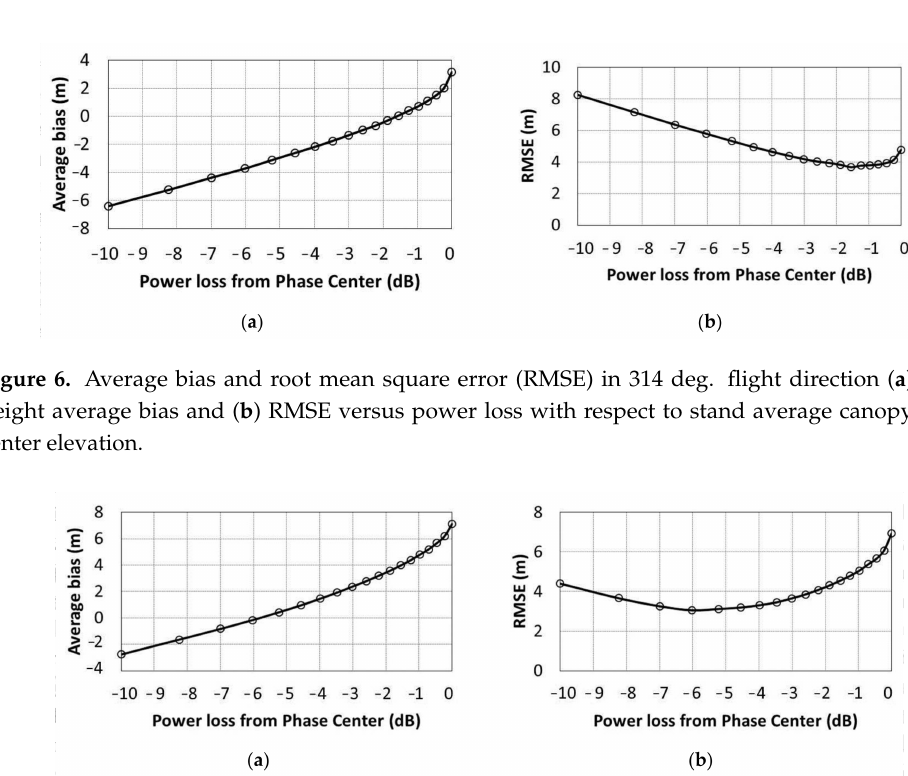
Figure 7. Average bias and RMSE in 134 deg. flight direction ( a ) Stand height average bias and ( b ) RMSE versus power loss with respect to stand average canopy phase center elevation.